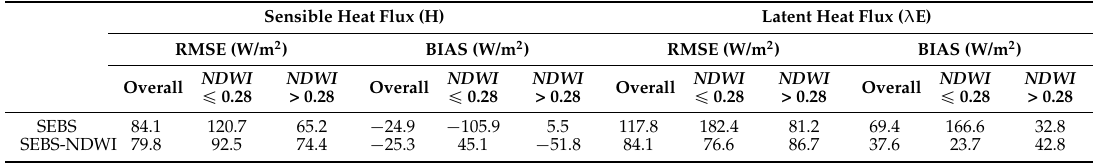
Figure 5. Comparison of modeled and observed surface turbulent fluxes at 16 stations in 2012. ( a ) and ( b ) show scatter plots of the measured and observed sensible heat fluxes from the original SEBS and the NDWI-integrated SEBS, respectively; ( c ) and ( d ) show scatter plots of the measured and observed latent heat fluxes from the original SEBS and the NDWI-integrated SEBS, respectively. Table 3. Error evaluations of the estimated sensible heat flux and latent heat flux from the original SEBS and the NDWI-integrated SEBS at 16 stations in